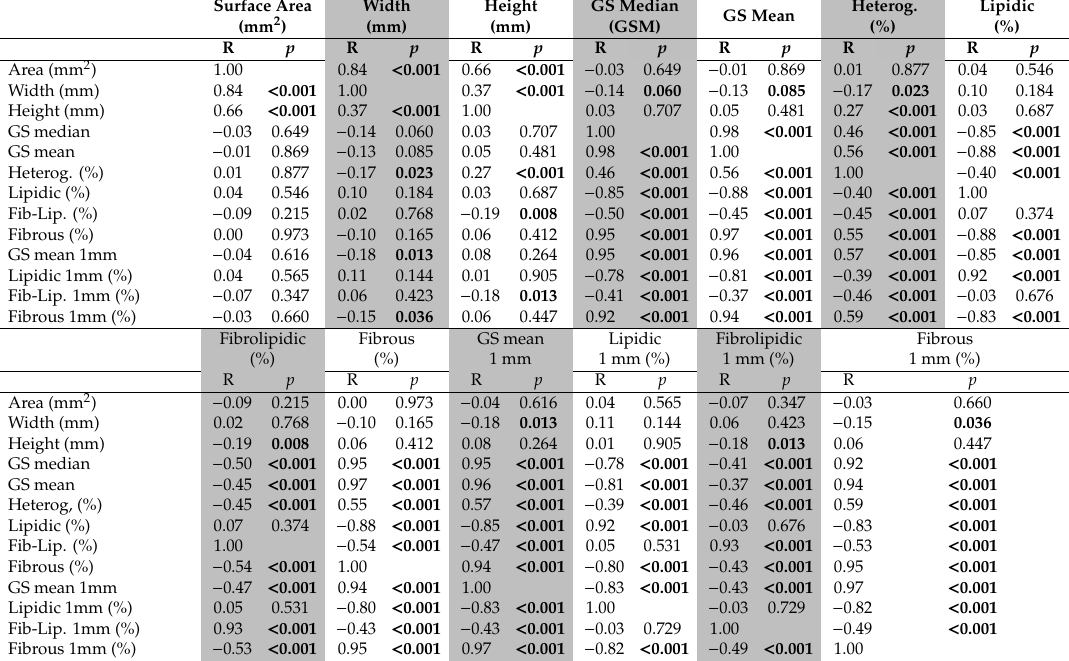
GS: grayscale. Fib-Lip.: Fibrolipidic. 1 mm: first (1st) atherosclerotic plaque superficial millimeter (layer). Heterog.: